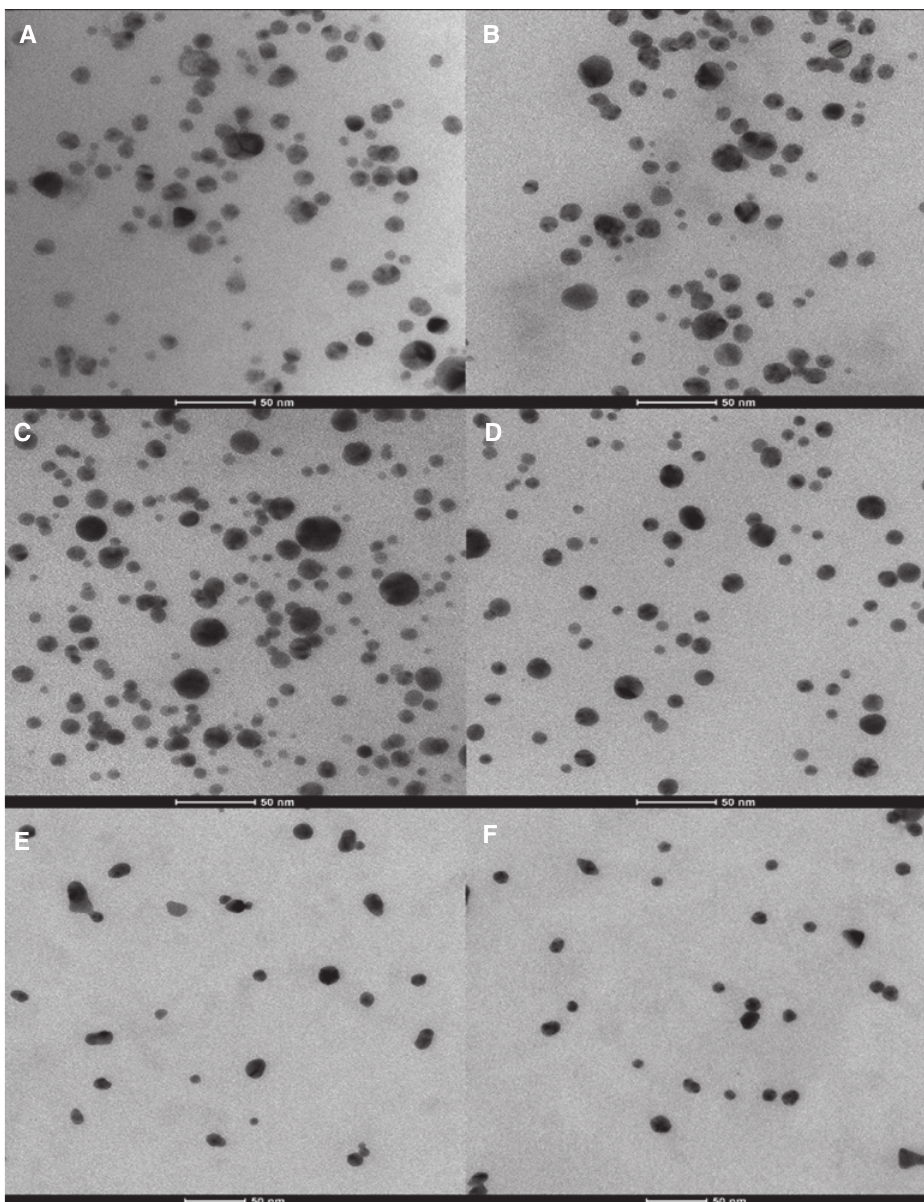
Figure 2: Transmission electron microscopy (TEM) images of: (A, B) Ag nanoparticles, (C, D) Au nanoparticles and (E, F) Ag33Au67 bimetallic